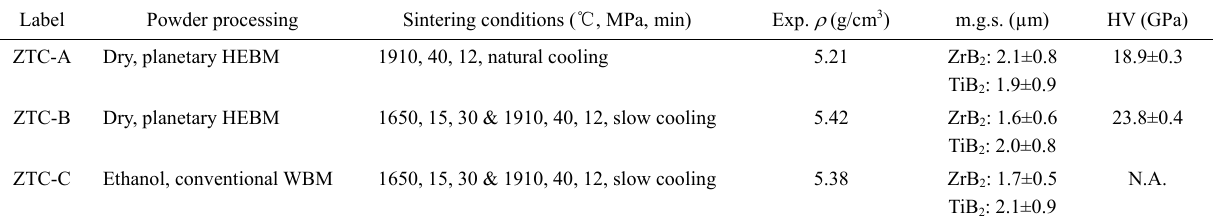
Table 1 Powder processing, sintering conditions, experimental density (  ), mean grain size (m.g.s.), and micro-hardness (HV) of the multi-phase ceramics. HEBM: high energy ball milling, WBM: wet ball milling Label Powder